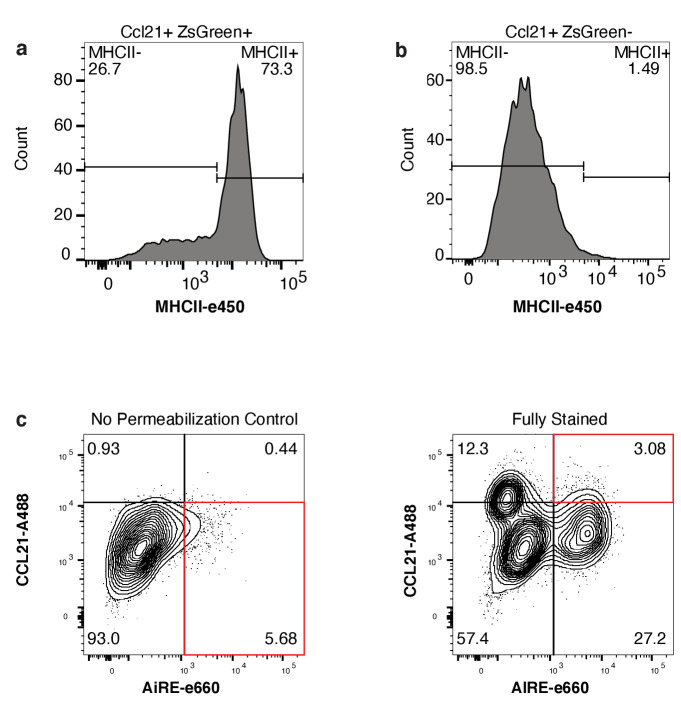
Classification of the CCL21 population by flow cytometry.(A) MHCII surface expression within the CCL21+ ZsGreen+ gated population. (B) MHCII surface expression within the CCL21+ZsGreen- gated population. (C) Analysis of CCL21 protein expression with and without a permeabilization step. Flow performed without permeabilization was used as a control to determine if the CCL21 population was detected internally or externally in mTECs.